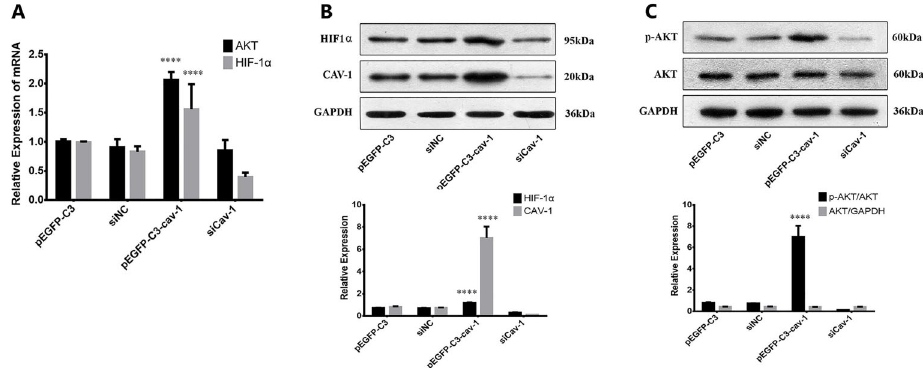
Figure 4. Cav-1 regulates p-Akt and HIF-1 a expression. U251 cells were transfected with pEGFP-C3, pEGFP-C3-Cav-1, siCav-1, or siNC. The mRNA expressions of Akt and HIF-1 a were determined by qPCR ( A ) and protein levels of HIF-1 a ( B ), and Akt and p-Akt ( C ) were assessed by western blot analysis. ****P o 0.0001 vs other groups (transfected with pEGFP-C3, siCav-1, or siNC; ANOVA) for n=3. NC: negative